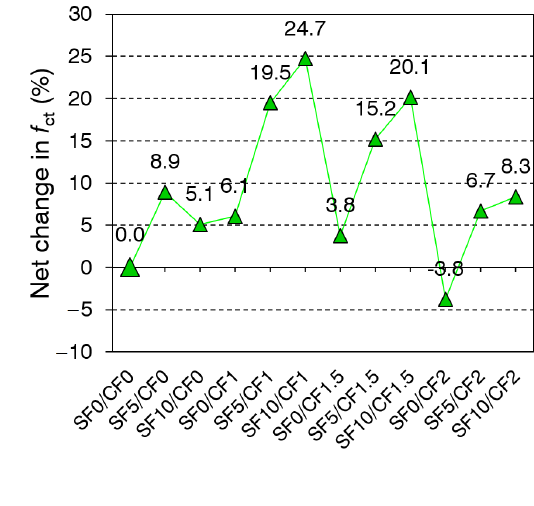
Figure 10. Relationship between shear strength and compressive strength as a function of C P (%).